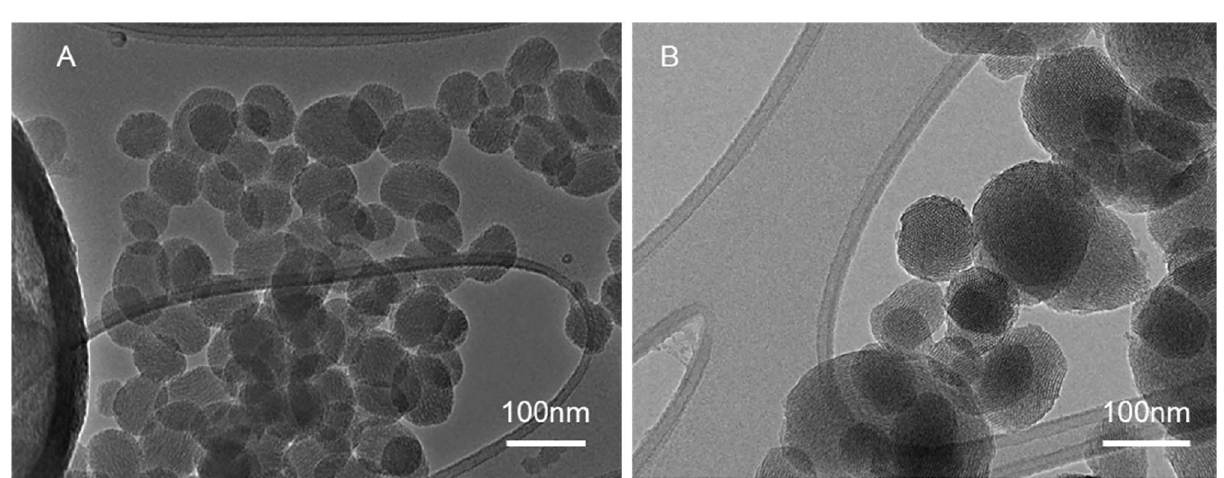
Figure 4. The morphology of the MSN did not significantly change after functionalization with PEG. ( A ) TEM image of MSN. ( B ) TEM image of